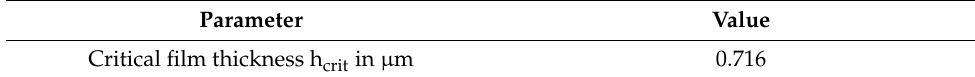
Table 5. Critical film